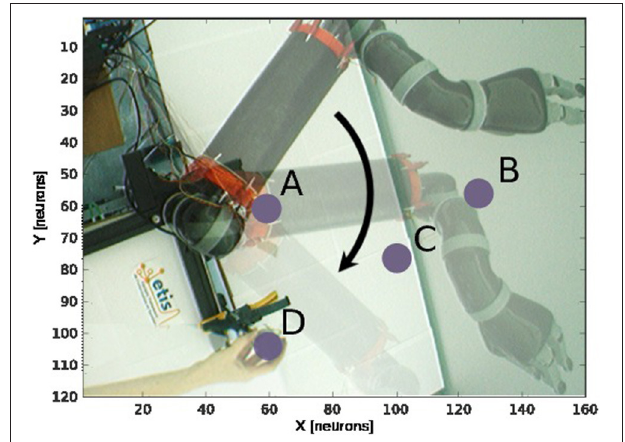
FIGURE 9 | Experience 2 – Target-centered receptive field. Experience done for fixed targets in four locations (A–D) when the arm moves.